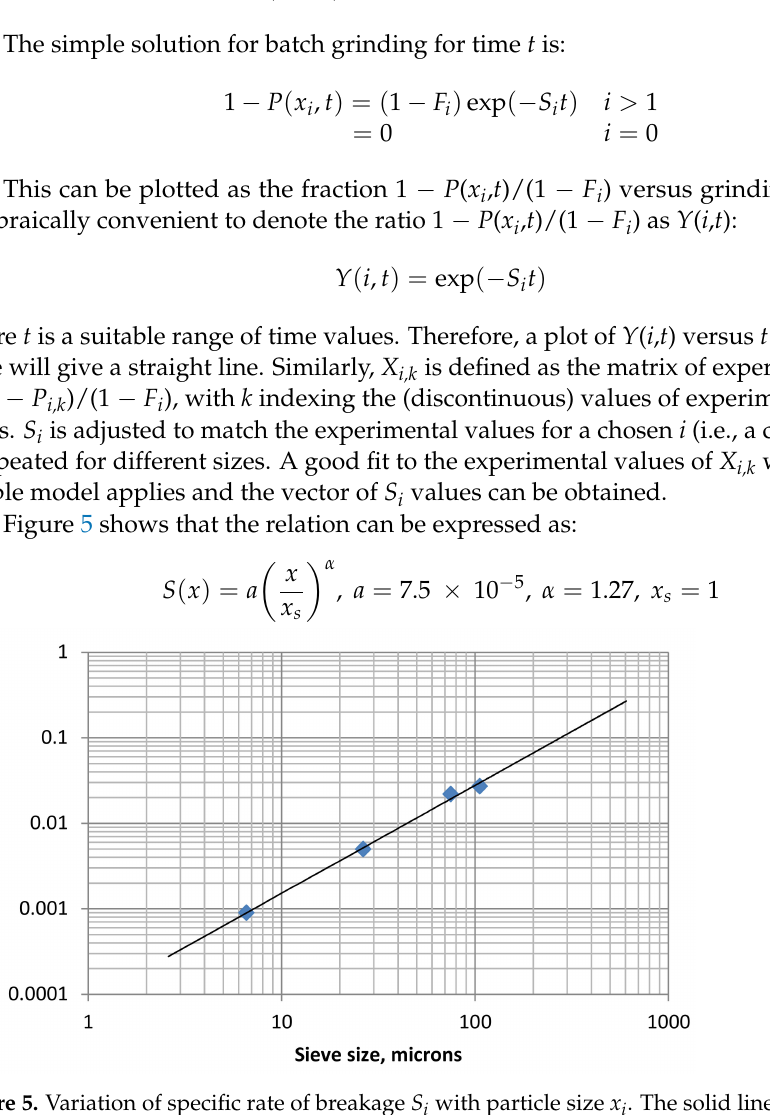
Figure 4. Example of fit of simple-model first-order disappearance according to Equation (7), shown as a solid line, for selected sizes (Run 1).